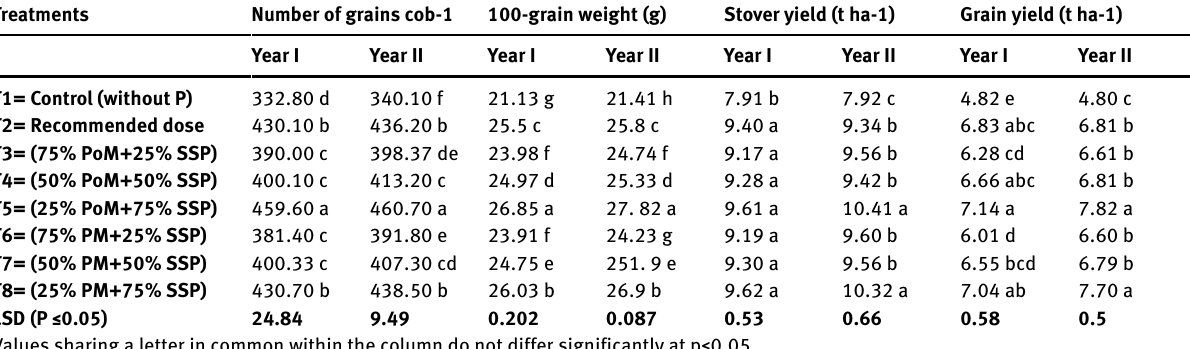
Table 4: Effect of integrated phosphorus management through organic manure and inorganic fertilizer on yield attributes of maize